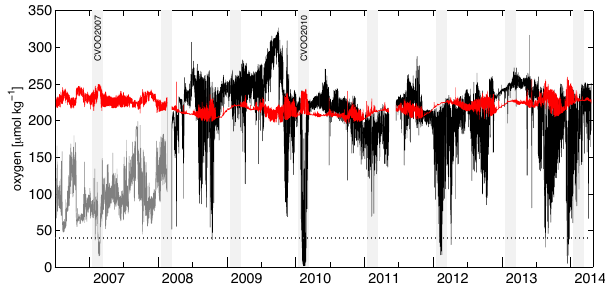
Figure 2. Time series of DO from the CVOO site at 40 to 60m depth (black line) and at 140m (grey line) during the beginning of the time series. The passage of the two anticyclonic-modewater eddies in February 2007 (CVOO2007) and February 2010 (CVOO2010) is labelled accordingly. The theoretical oxygen surface saturation (red line) is shown, as well as the 40µmolkg − 1 threshold reported in the literature. The period from 15 January to 15 March for each year is indicated by grey-shaded